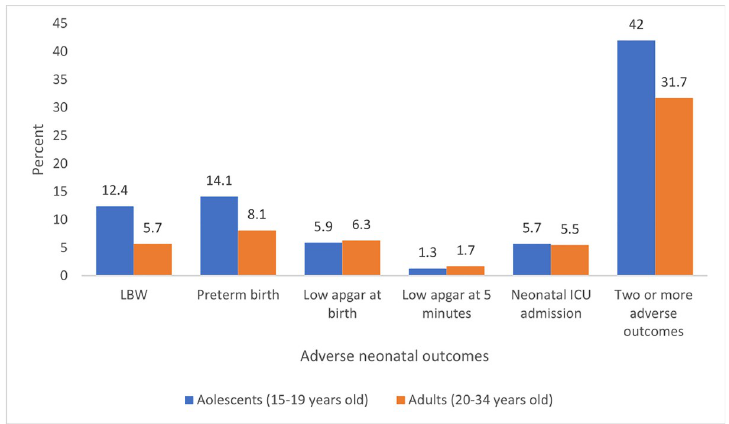
Fig 3. Adverse neonatal outcomes among adolescent and adult women who gave birth in public health facilities, East Gojjam zone, Northwest Ethiopia, 2018.